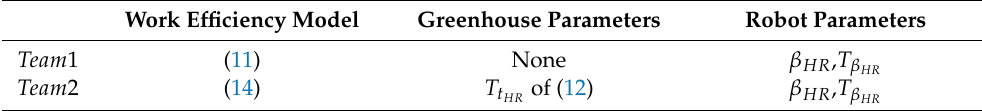
Table 2. The work efficiency model parameters related to the greenhouse and